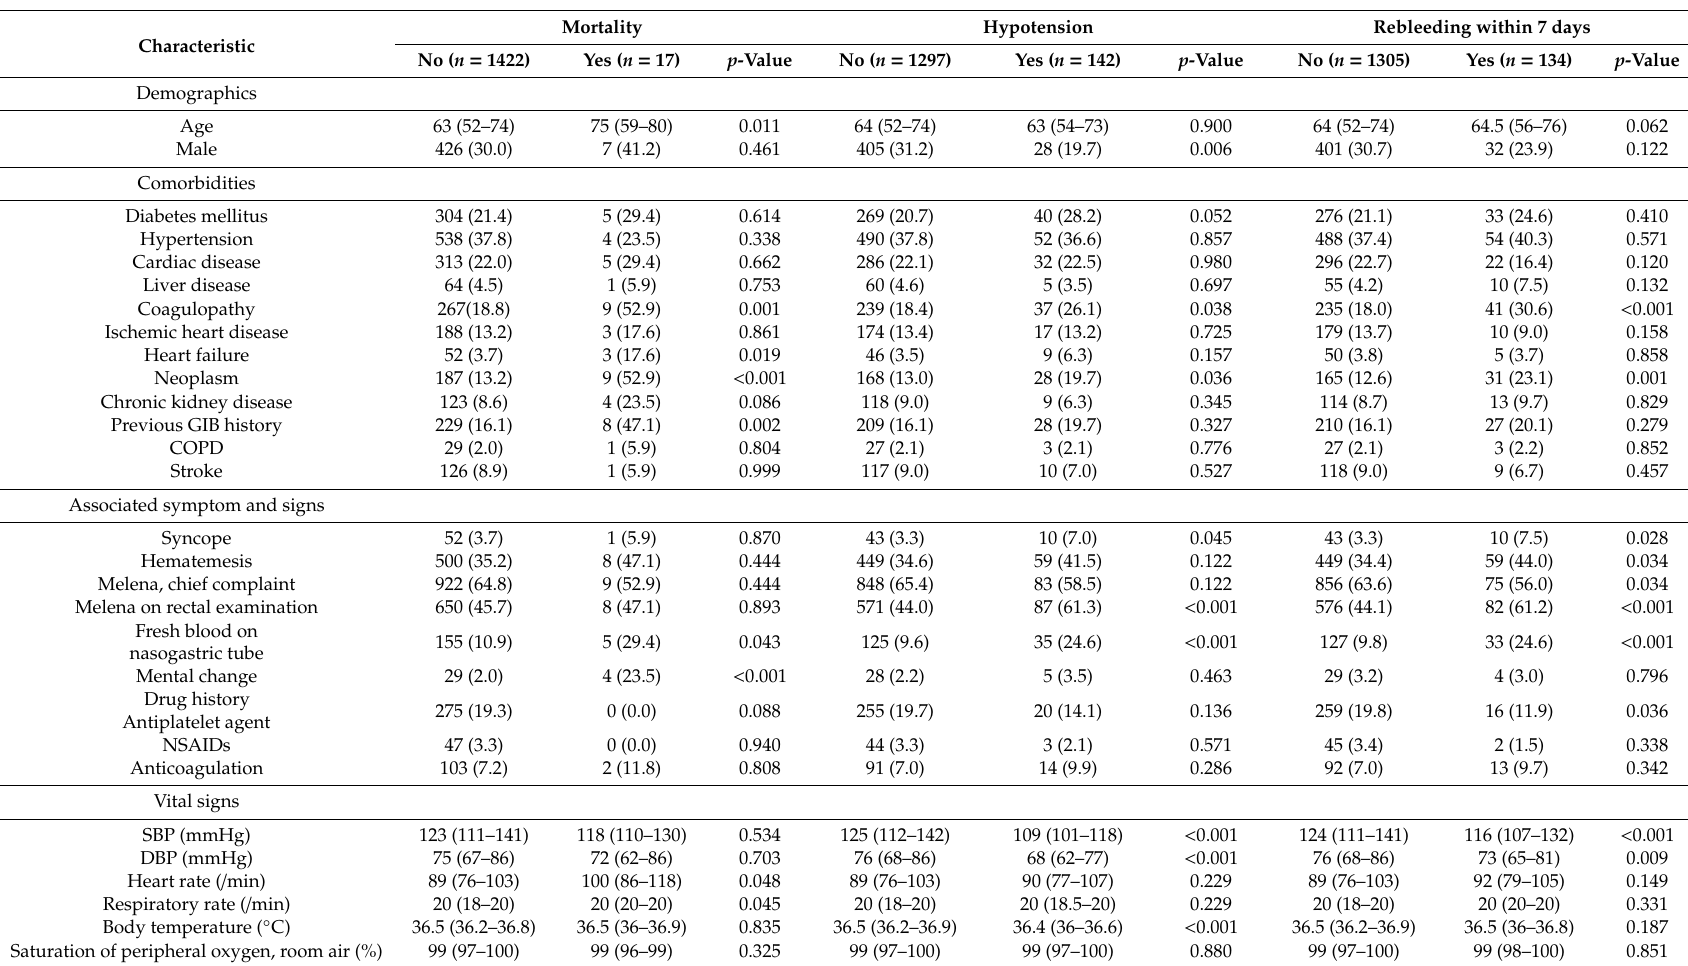
Table 1. Statistical characteristics of the two groups divided by the mortality, hypotension, and rebleeding within 7 days classes in the study population.